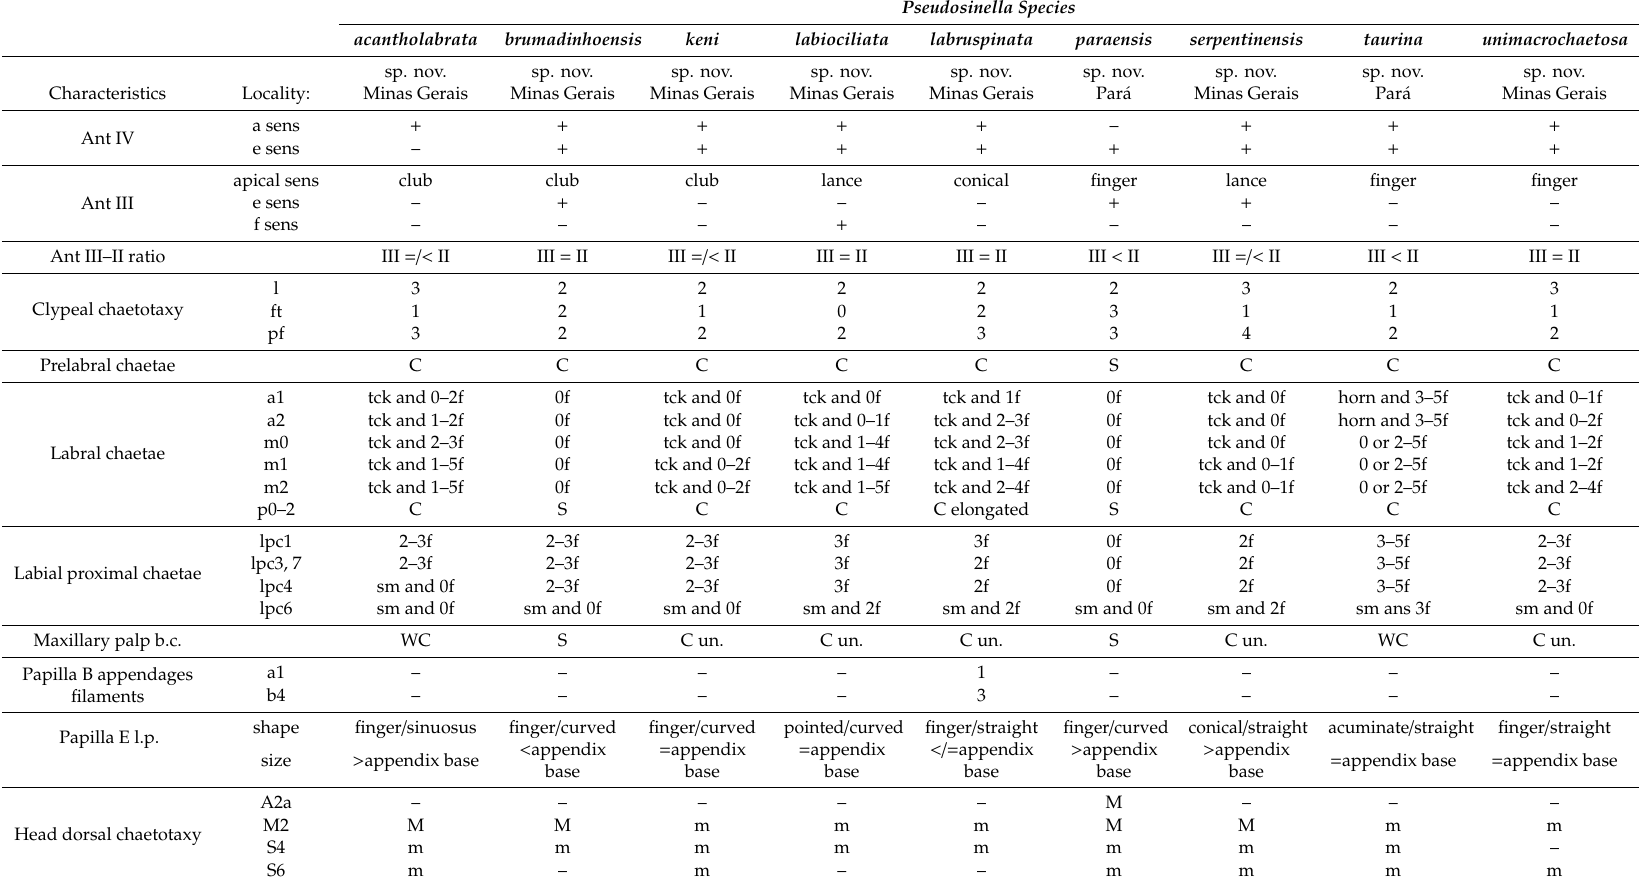
Table 3. Comparison (per side) among new species of Pseudosinella from Brazil with large tooth on pe lamella of unguiculus, labial field with r chaeta reduced, Abd II with 2 mac (m3, m5), and furcula only with ciliate chaetae, devoid of pigments, eyes and apical bulb on Ant IV.